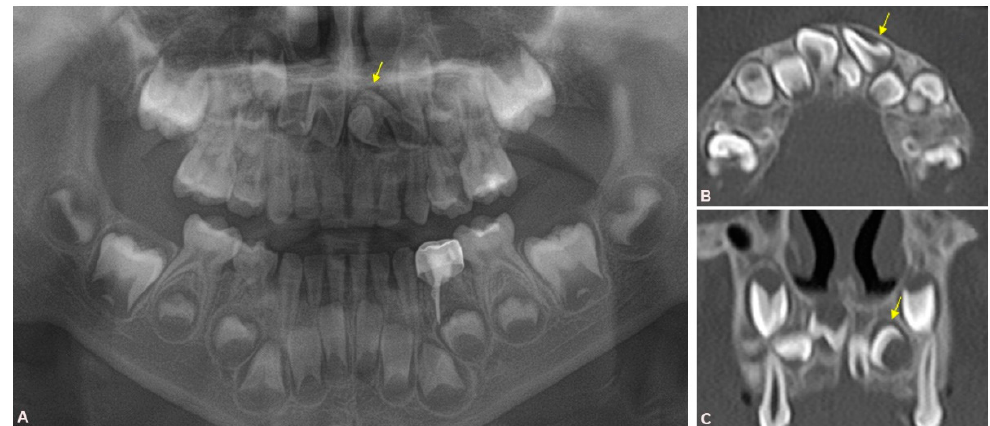
Figure 1. Preoperative X-ray, ( A ) Preoperative panoramic view shows the inverted mesiodens and maxillary central incisor impaction; ( B ) Axial view of computed tomography (CT) shows buccolingual inverted central incisor; ( C ) Coronal image of the CT, arrow: inverted central incisor.